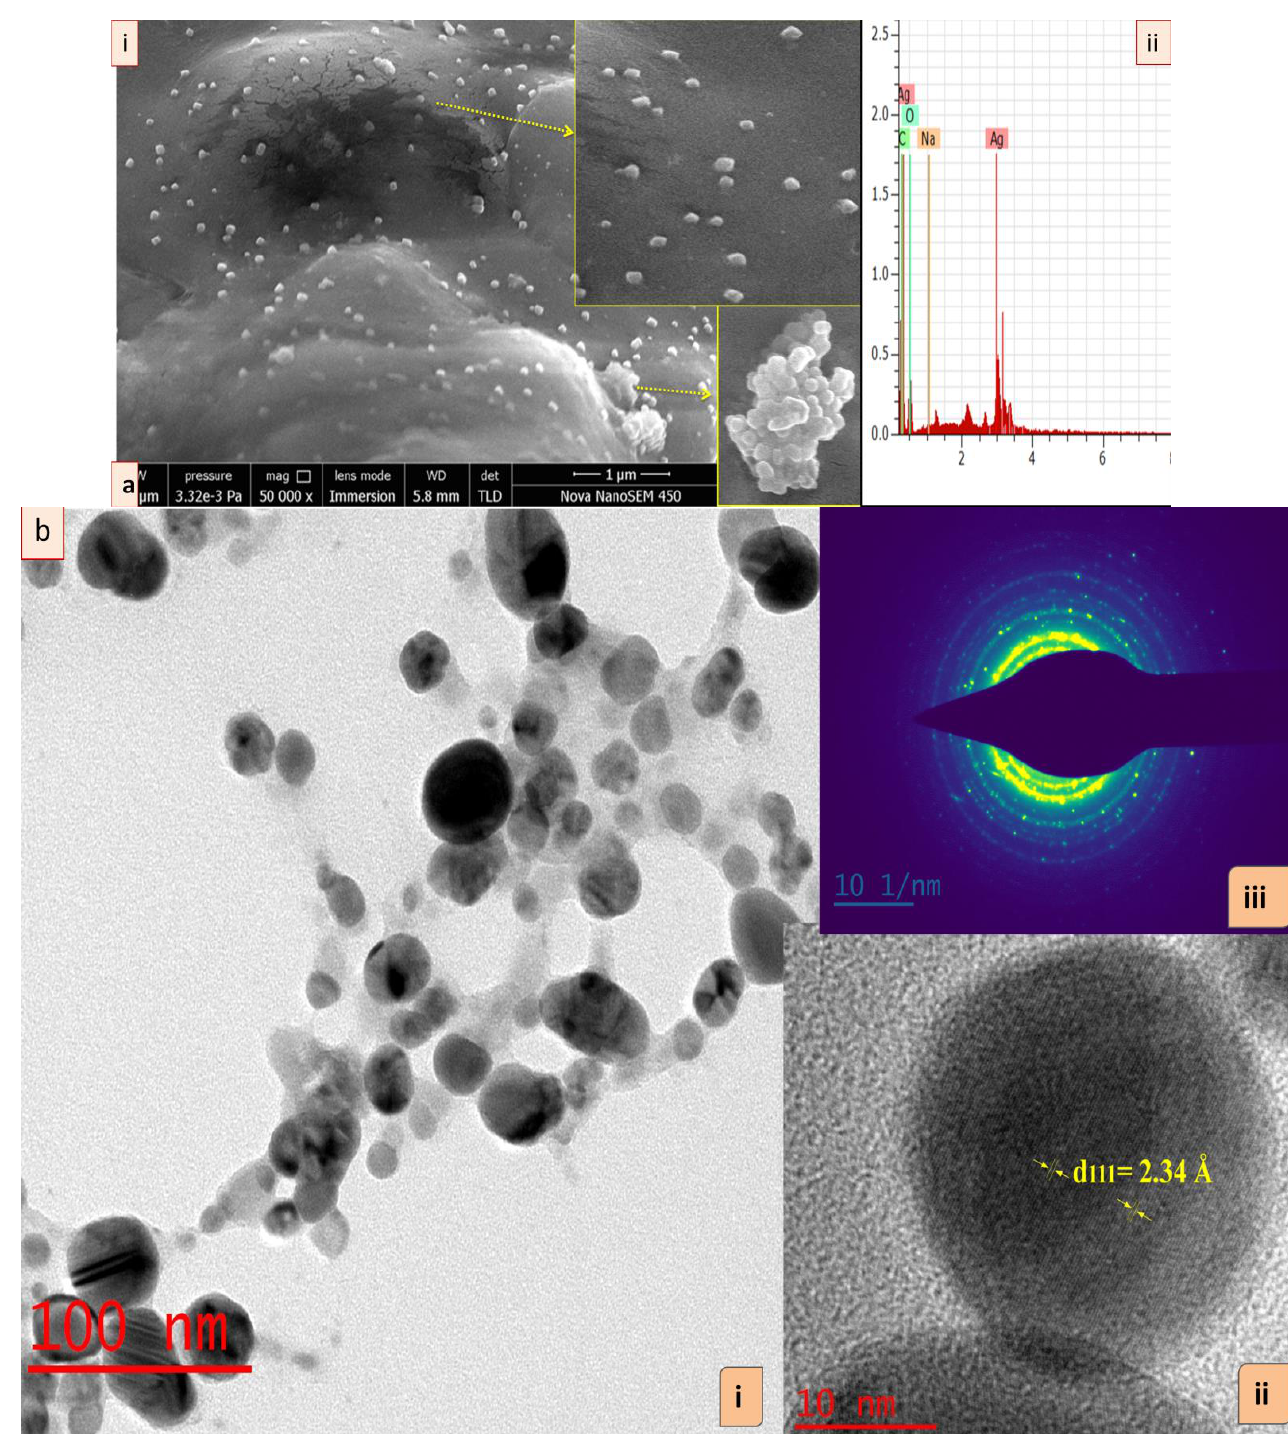
Figure 2. Characterization of silver nanoparticles synthesized using aqueous root extract of G. glabra (GRAgNPs). ( a ) (i) Field emission scanning electron micrograph of GRAgNPs at 50 kx magnification, (ii) Energy Dispersive X-ray spectrum of synthesized GRAgNPs, ( b ) HRTEM micrograph of GRAgNPs (i) spherical shape of NPs, (ii) single spherical GRAgNP and (iii) Ring SAED pattern of polycrystalline GRAgNPs. Insets showing enlarged